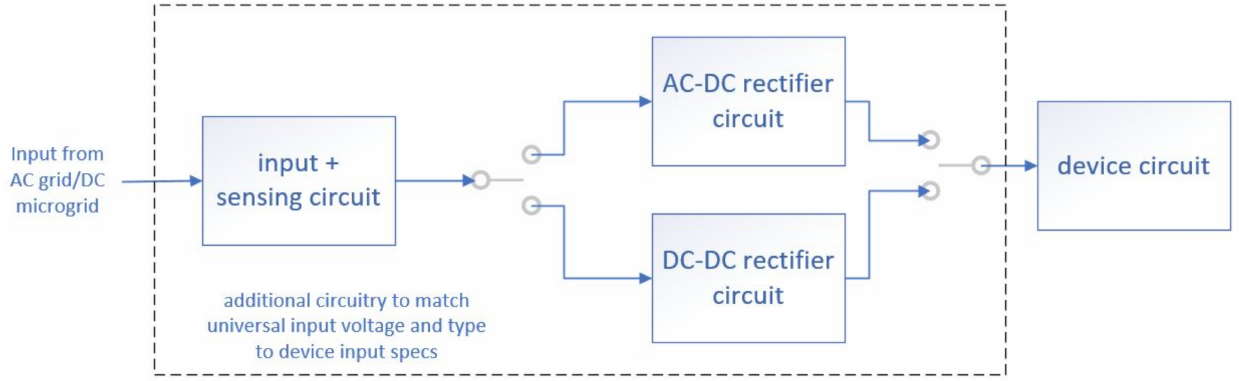
Figure 10. Conceptual design of a universal input device